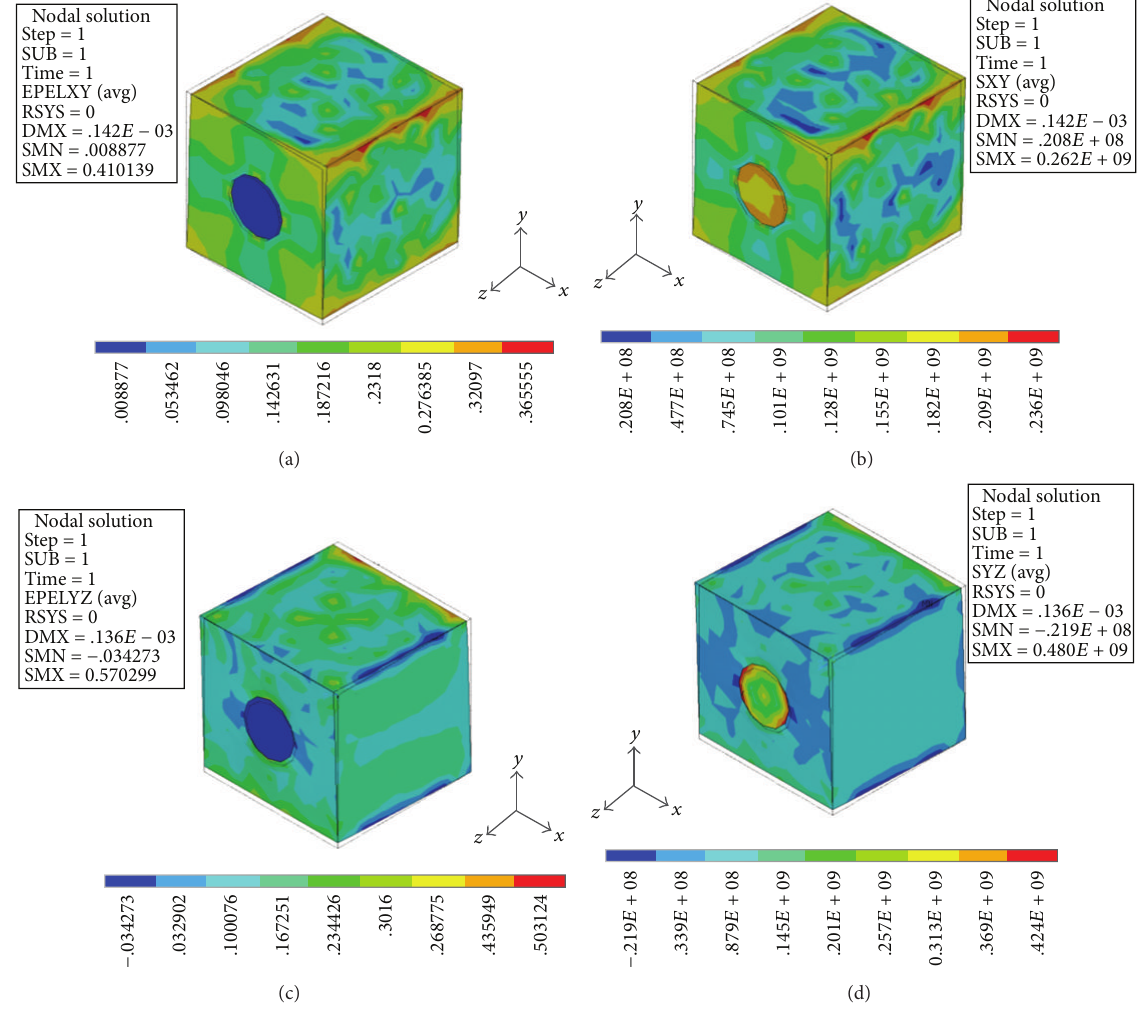
Figure 16: RVE nodal solutions for c 44 and c 66 using 3D